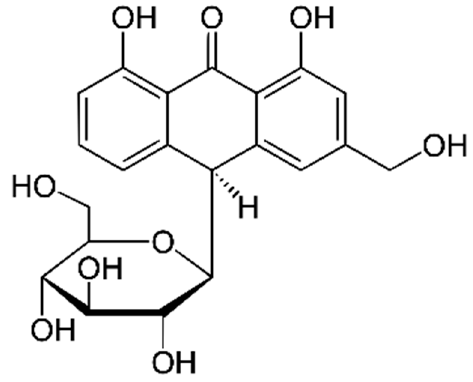
Figure 1. Chemical structure of aloin.